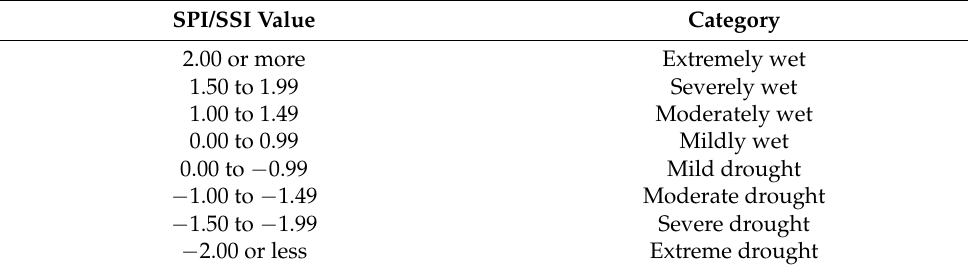
Table 2. Drought classification according to SPI/SSI method